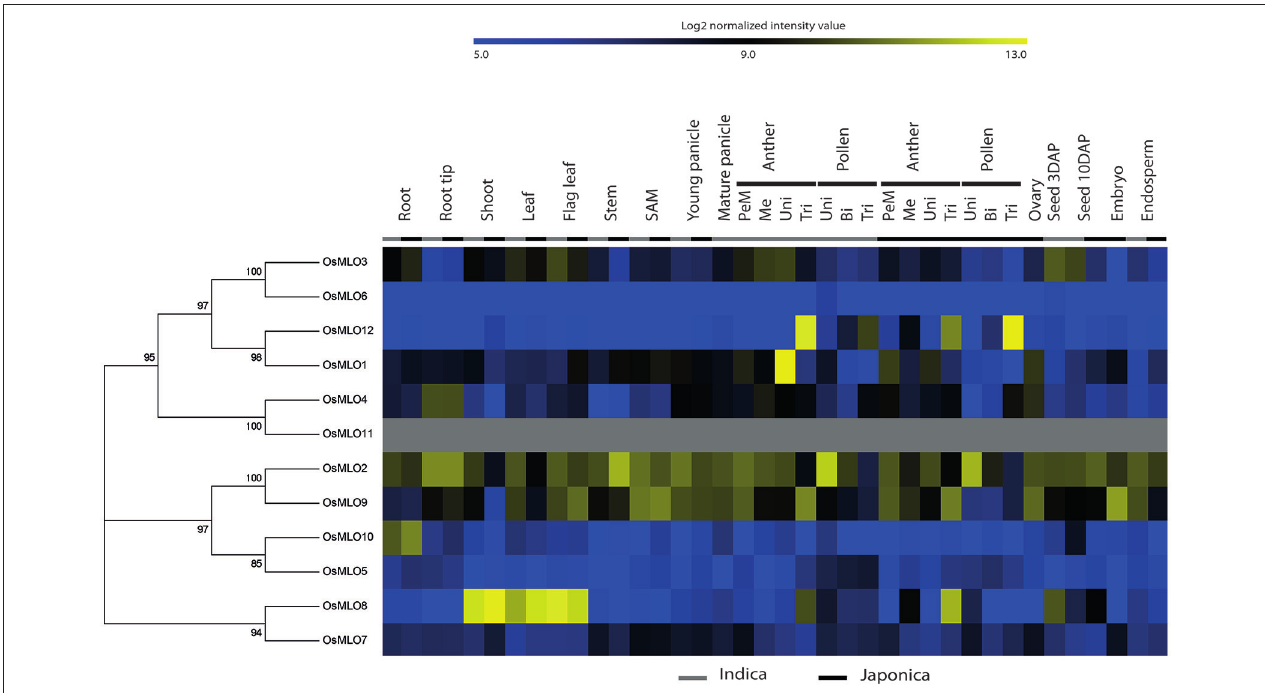
FIGURE 1 | Meta-analysis of OsMLO gene expression patterns using 983 Affymetrix anatomical array data. Blue, low level of log 2 intensity; yellow, high level. Gray bar, indica samples; black bar, japonica samples. OsMLO11 has no probe on rice Affymetrix chip. SAM, shoot apical meristem; PMe, pre-meiotic; Me, meiotic; Uni, uninucleate stage; Bi, binucleate stage; Tri, trinucleate stage; DAP, days after